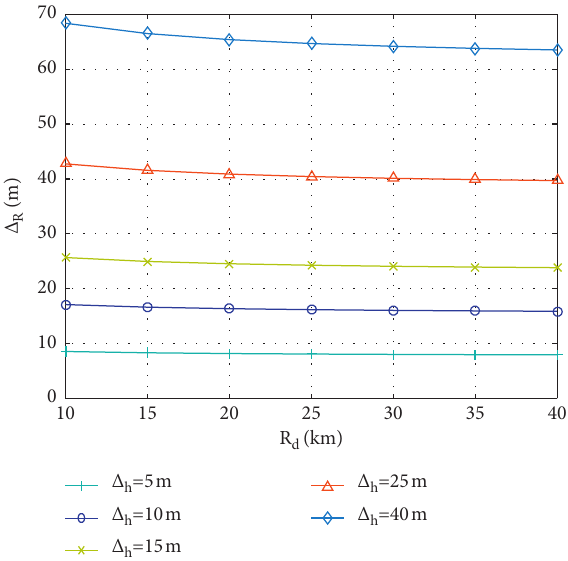
Figure 5: The relationship between multipath range deviation and reflection surface deviation.